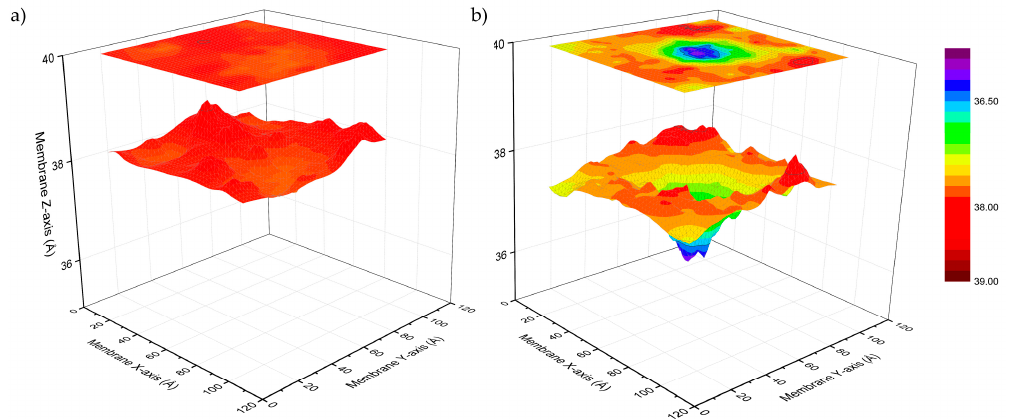
Figure 3. Thickness maps of POPC/POPG/ALY (a) and POPC/POPG/azoALY (b) during the last 5 ns of the MD simulation (total time 50 ns). The top panel is the deformation profile as a color map projected onto the surface defined by fitting a grid (spacing 2 Å) to the positions of the phosphate atoms in the top leaflet during the trajectory, followed by time averaging and spatial smoothing.